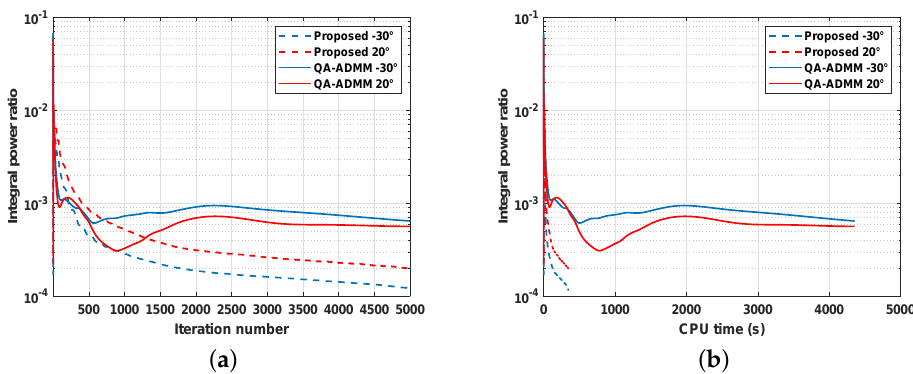
Figure 12. The comparison of algorithm efficiency. ( a ) Integral power ratio vs. iteration number. ( b ) Integral power ratio vs. CPU